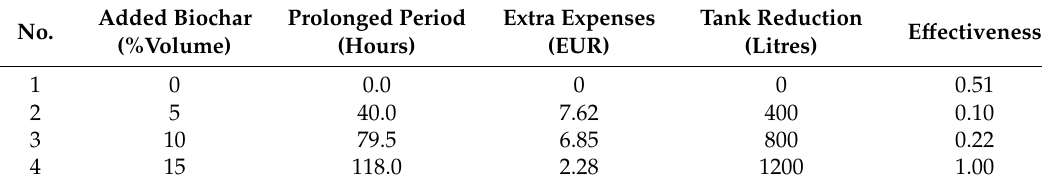
Table 4. Results for the sample thickness of 100 mm.